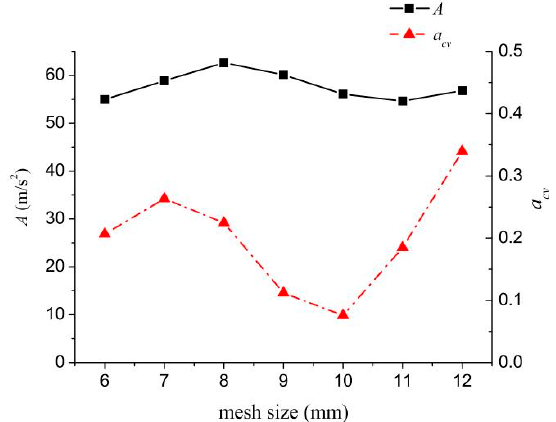
Figure 3. Sensitivity analysis of mesh size.